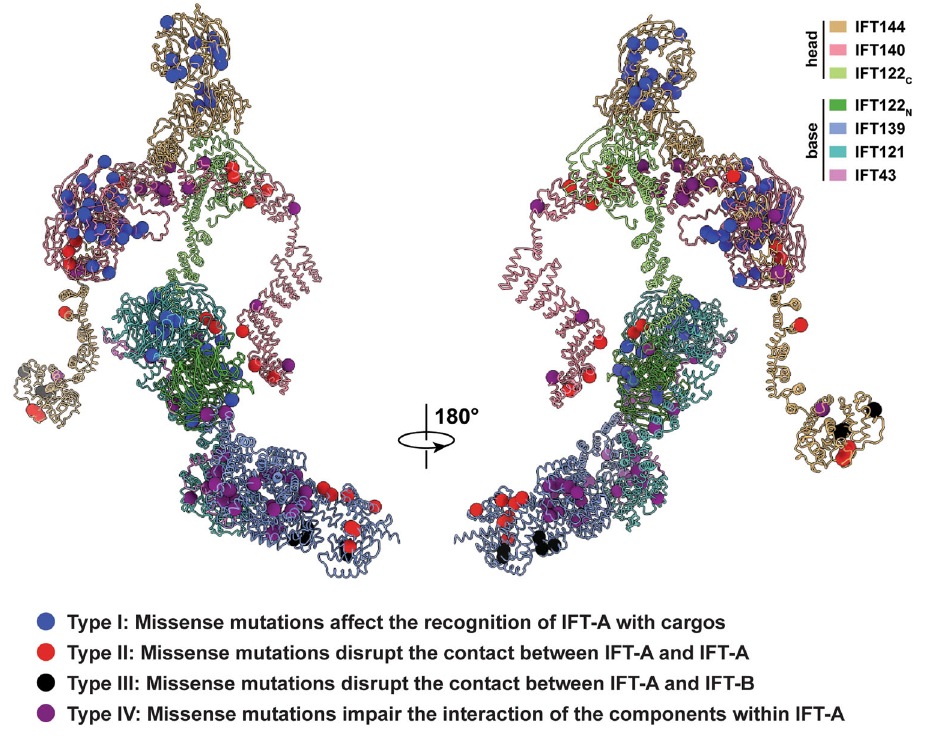
Fig.5|SummaryofmissensemutationsintheIFT-Acomplex. ThepathogenicmutationsofIFT-Acanbedividedintofourdistinctcategories(typeI,II,IIIandIV)based on their roles in cargo delivery or IFT train